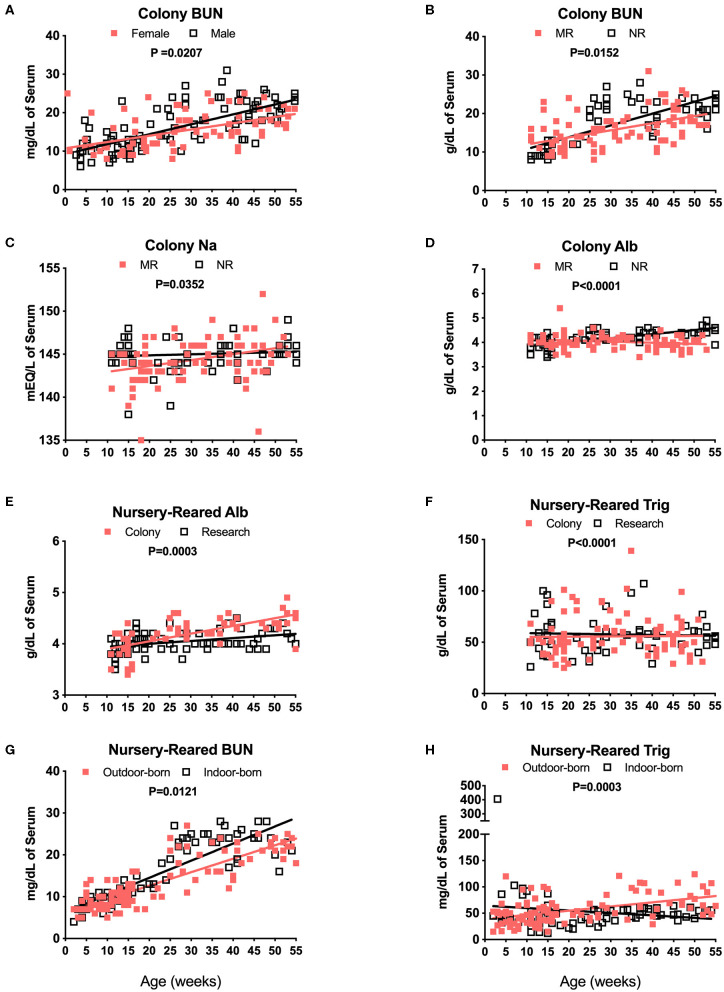
Analysis of blood chemistry values affected by breast milk (MR animals) vs. formula (NR animals), sex, and birth site. Linear regression and ANCOVA were was performed to compare slopes for male and female colony animal BUN data over age (Male: slope = 0.258, R2 = 0.4954; Female: slope = 0.1626, R2 = 0.2547) (A) and Colony MR and Colony NR animal BUN (MR: slope = 0.185, R2 = 0.2376; NR: slope = 0.3067, R2 = 0.5684) (B). Comparisons over age were plotted to compare Colony NR and Colony MR animals for changes over age at sample collection time in levels of Na (MR: slope = 0.0687, R2 = 0.1139; NR: slope = 0.012, R2 = 0.009) (C) albumin (Alb, MR: slope = −0.0047, R2 = 0.0403; NR: slope = 0.0167, R2 = 0.4709) (D) and triglycerides (Trig, MR: slope = 0.0245, R2 = 0.0002; NR: slope = −0.0566, R2 = 0.0022) (E). Colony NR and Research NR animals were compared over age for levels of Alb (Colony: slope = 0.015, R2 = 0.4552; Research: slope = 0.0056, R2 = 0.1387) (F), and NR animals born indoors and outdoors were compared over age for BUN (Outdoor: slope = 0.3222, R2 = 0.7243; Indoor: slope = 0.4091, R2 = 0.7332) (G), and Trig (Outdoor: slope = 0.7941, R2 = 0.2419; Indoor: slope = −0.4637, R2 = 0.0217) (H).